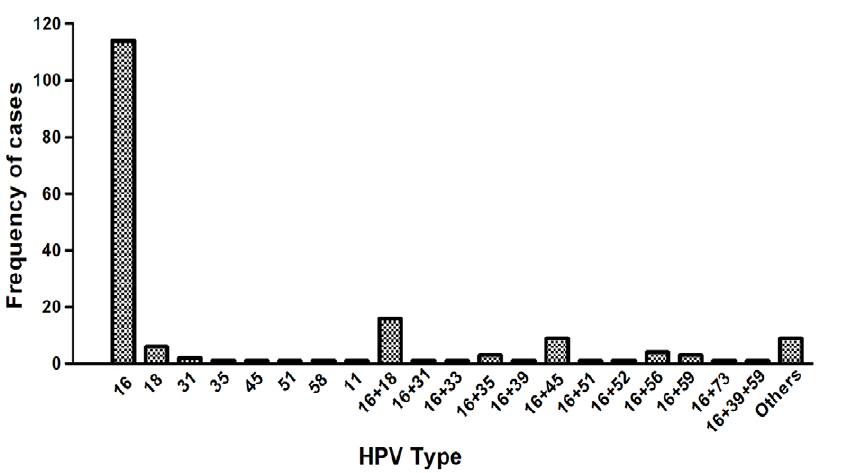
Figure 2. Frequency of 24 HPV types as detected by Luminex array. The graph depicts frequency of 24 HPV types in 178 cervical cancer biopsy samples which were found to be positive GP5 + /6 + primers. HPV16 infection predominated in the samples. Each bar represents different HPV types.